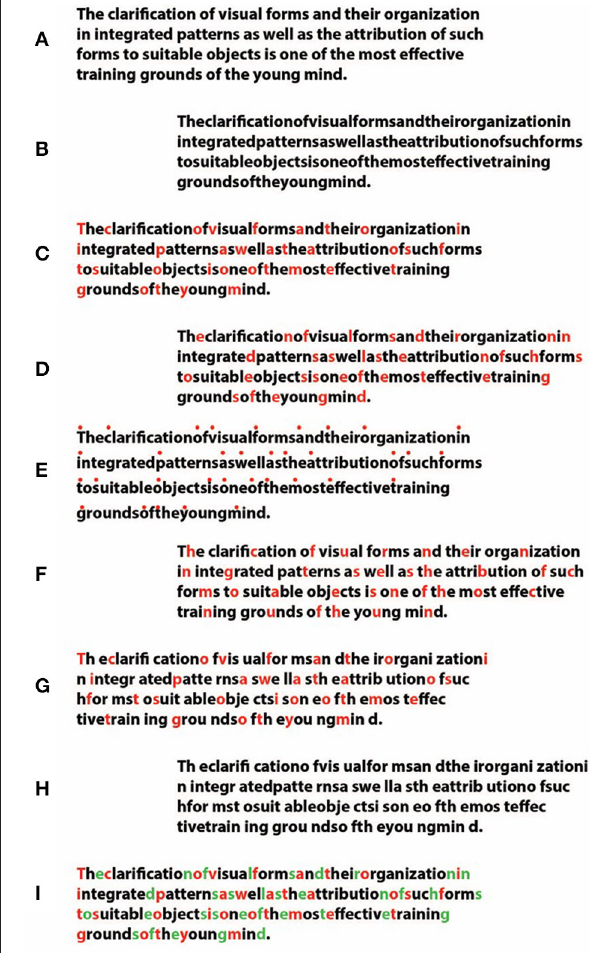
FIGURE 13 | Accentuation plays a clear role in making it easier (C,D,E,F,G,I, cf. with the controls A,B,H) to read Arnheim’s quote. It also makes the reading faster or induces a delay and improves or makes it worse the comprehension of the text. These phenomenological results are confirmed by the ones of the magnitude estimation task [ F (8 , 13) = 8.2, P <